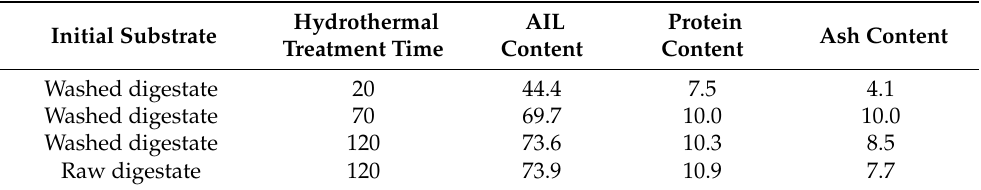
Table A3. Acid-insoluble lignin (AIL) content, protein content and ash content in solid residues remaining after hydrothermal and enzymatic treatment (determined as described in Section 2.3.1).